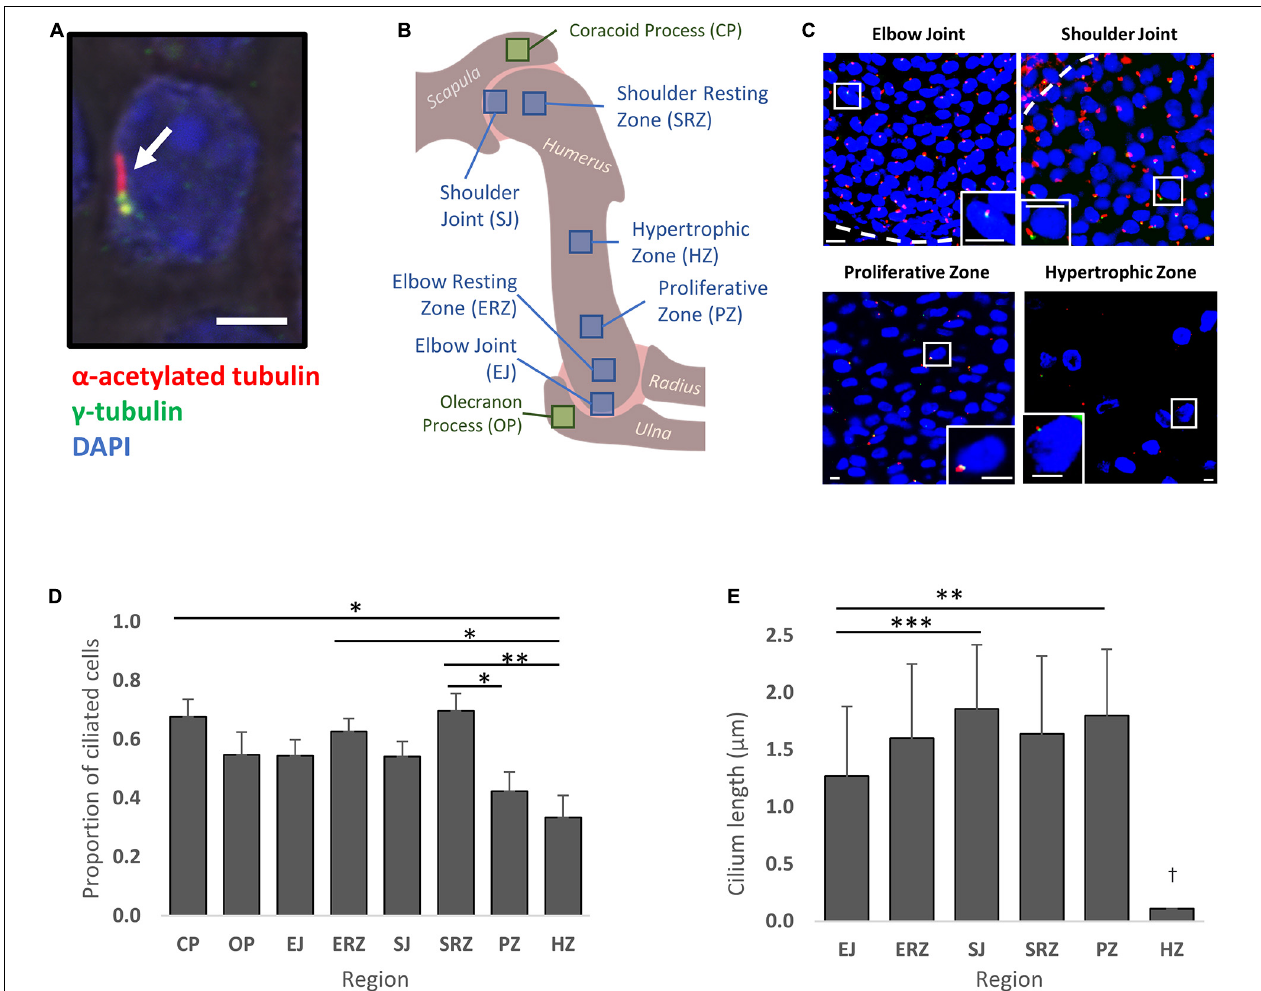
FIGURE 2 | Cilia are present on chondrocytes throughout the normal developing skeletal rudiment at TS23, with some variation in the proportion of ciliated cells and length of cilia detected by region. (A) Representative image (confocal) of a primary cilium (white arrow) on a chondrocyte within the developing humerus at TS23; scale bar is 2 µ m. (B) Schematic of the developing humerus and associated joints, with sampled territories indicated by blue (within the humerus) and green boxes. (C) Representative fluorescent images of cilia in selected regions of the developing humerus; scale bar is 10 µ m. Inset boxes show zoomed images of representative ciliated cells. Dashed lines indicate the joint line. (D) Proportion of total cells (DAPI + ve) with primary cilia detected ( α and γ tubulin + ve) by region (abbreviations as indicated in B ). (E) Cilium length by region. Cilia in the hypertrophic zone (HZ) were much shorter; precise measurement was not possible by the approach used but was estimated to be approx. 0.11 µ m ( † ) (not analyzed statistically). Significance in (D,E) calculated using one-way ANOVA with post hoc Tukey’s tests; ∗ p < 0.05, ∗∗ p < 0.01, ∗∗∗ p < 0.005. N = 4 independent specimens for occurrence measurements; n = 3 for length